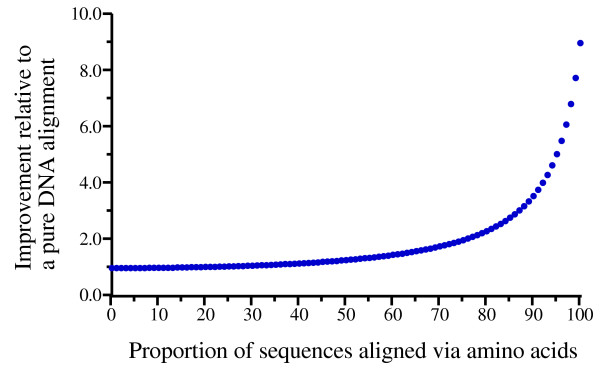
Theoretical gain in speed from performing a translated alignment. The figure reveals there is always a performance advantage in aligning any given proportion of the protein-coding DNA sequences in a data set via their amino-acid translations with the remaining DNA sequences subsequently profile-aligned to them. The curve as shown is based on the assumption that the translated alignment is 9x faster, on average, than the respective DNA alignment; other values produce nearly identical curves of different scales.